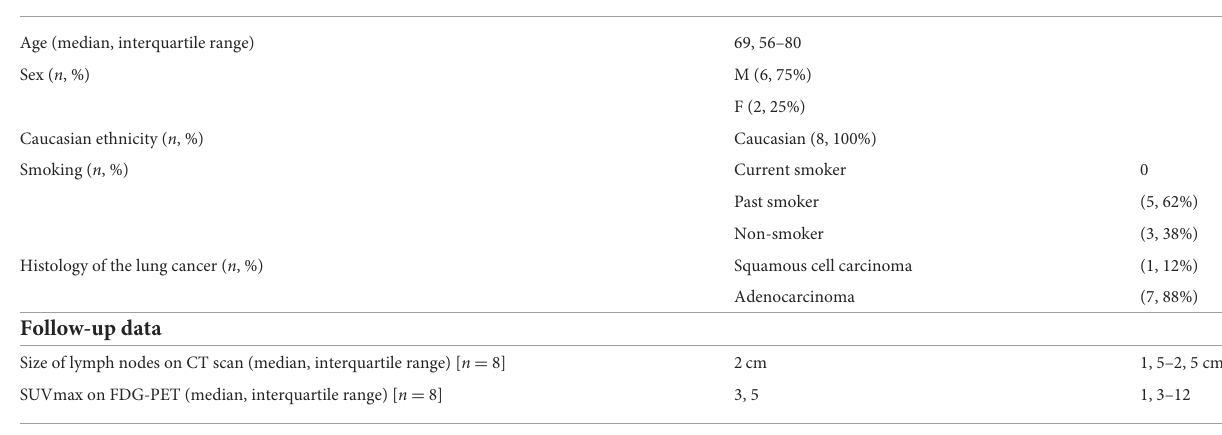
TABLE 1 Demographic, clinical, imaging, and histopathological data of the patients included in this case series. Pre-operative data